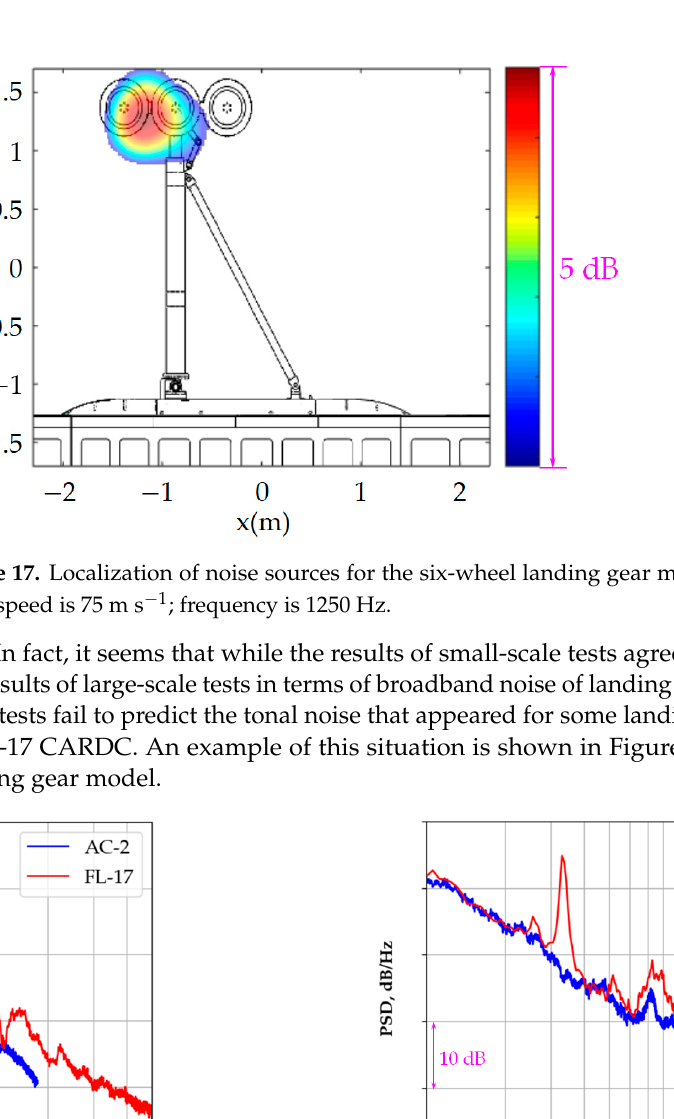
( b ) Figure 16. Comparison of the normalized spectra of the six-wheel landing gear model. Microphone